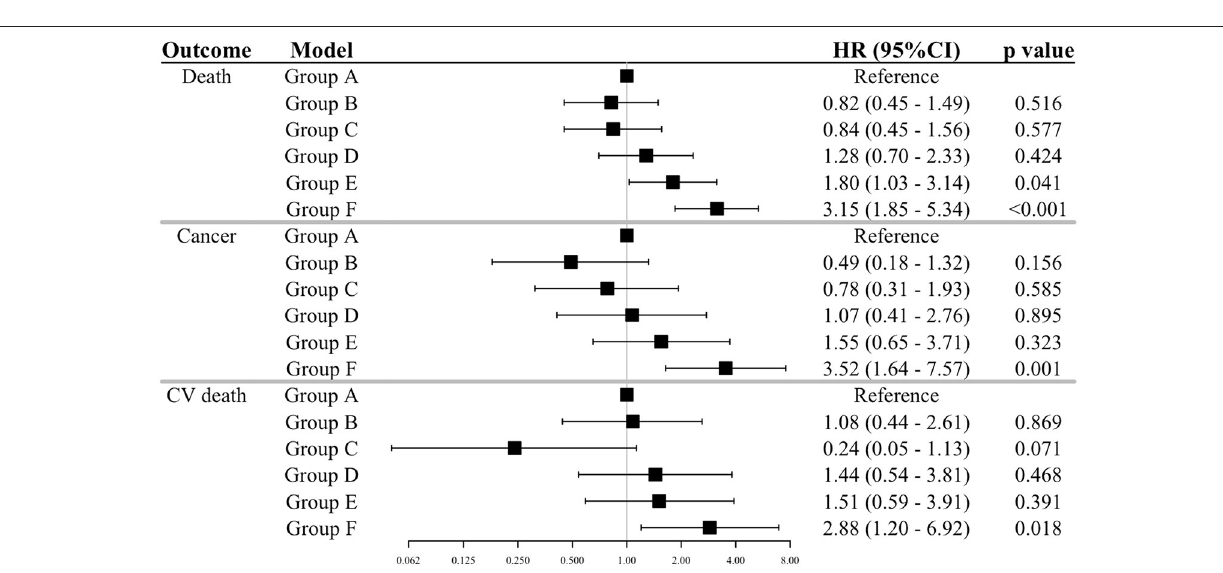
excluded at baseline, so the outcome of cancer death implied that the patients developed malignancy and died of advanced cancer. Given that the mean follow-up period was 6.6 years,